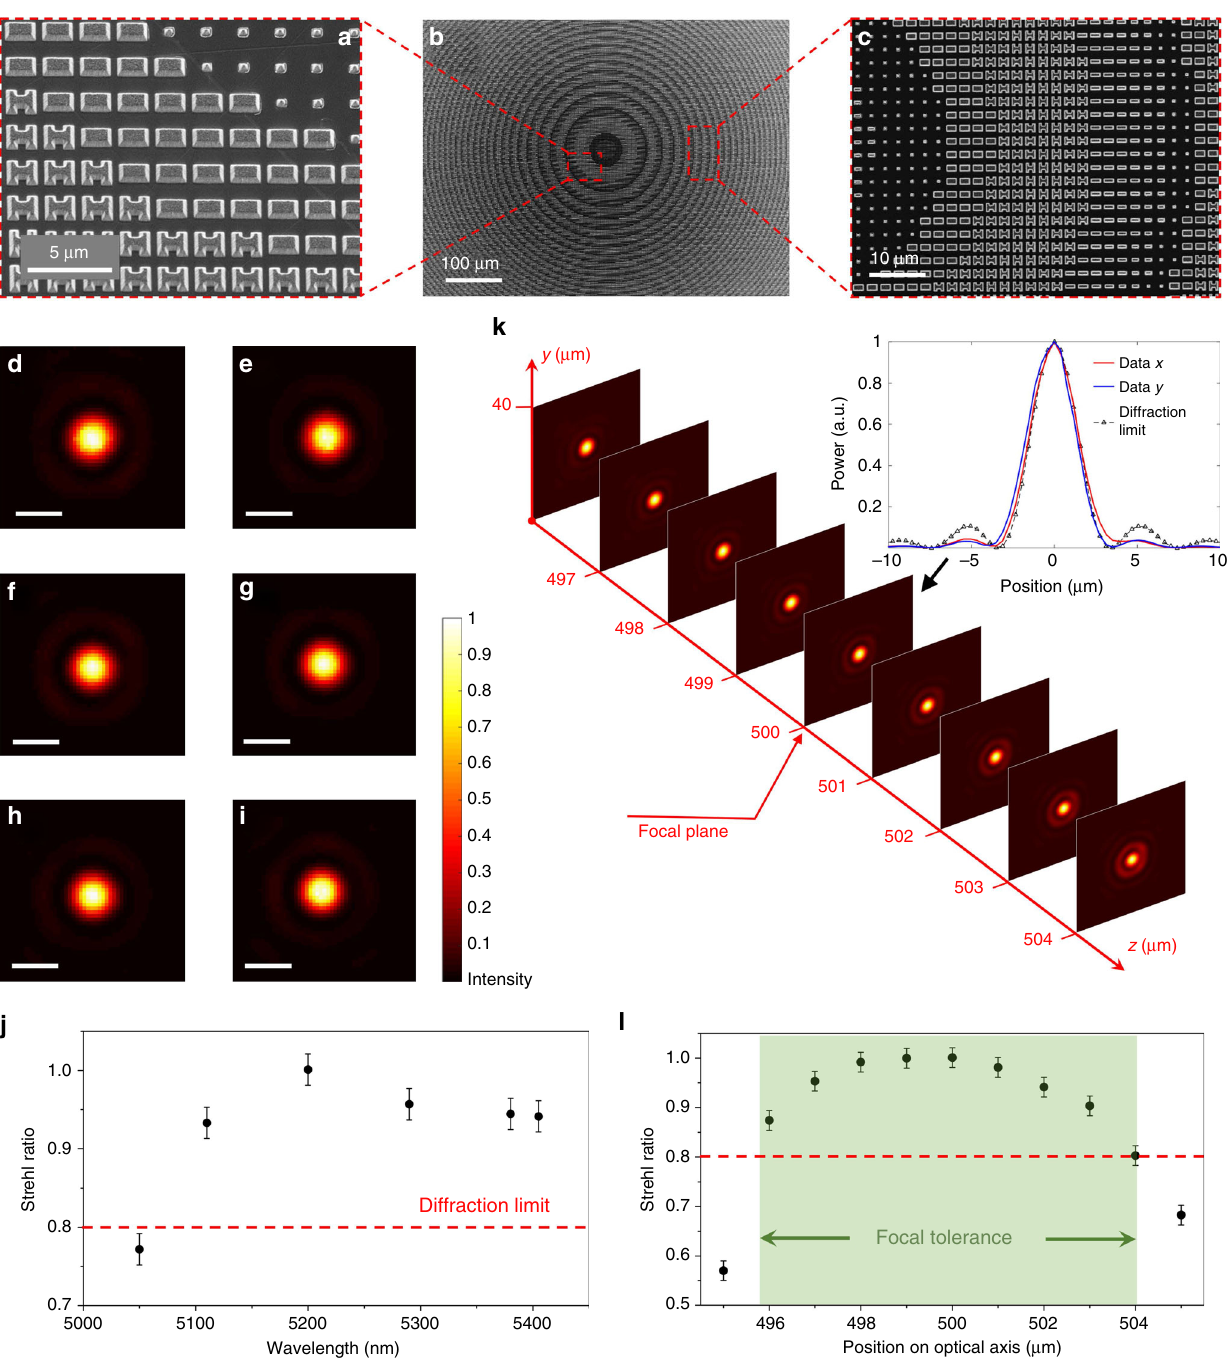
Fig. 5 Characterization of aspherical meta-lens. a – c Top-view SEM micrographs of the fabricated aspheric meta-lens; d – i measured aspheric lens focal spot pro fi les at the wavelengths of d 5050nm, e 5110 nm, f 5200 nm, g 5290nm, h 5380 nm, and i 5405 nm; the scale bar represents 5 μ m; j measured Strehl ratios as a function of wavelength; k focal spot pro fi le evolution along the optical axis at 5200 nm wavelength; inset: measured intensity distributions of the focal spot at 5200 nm wavelength along x - and y -directions on the focal plane in comparison with diffraction-limited focal spot pro fi le. The measurement data are normalized such that the total power on the focal plane (rather than peak intensity) equals that of the diffraction-limited focal spot; l Strehl ratios measured on the optical axis: the shaded region corresponds to focal tolerance of the meta-lens. Error bars for panels j and l are explained in Supplementary Note